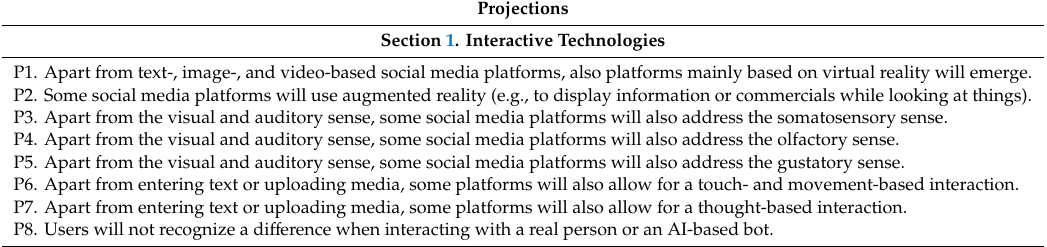
Table 1. Projections for the Delphi